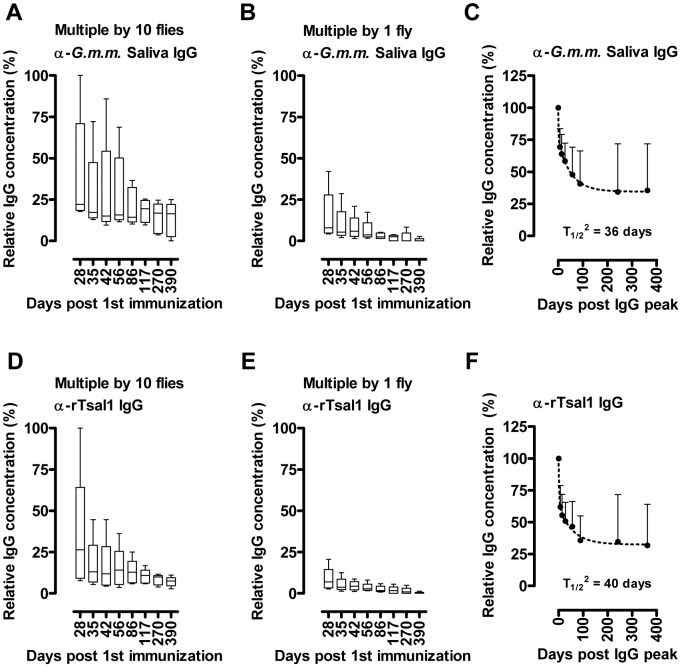
Antibody kinetics in tsetse exposed mice.Evolution over time in the absence of tsetse fly challenge (from day 28 onwards) of the anti-G. m. morsitans saliva IgG concentrations (A, B, C) and the anti-rTsal1 IgG concentrations (D, E, F) in mice (n = 5/group) exposed multiple times to a single fly (B, E) or 10 flies (A, D). Presented data are the IgG concentrations relative to the highest responder plasma and expressed as percent based on a standard dilution series. Box plots represent the means, with minimum and maximum and the 75-25% percentiles. The average antibody half-life (T1/2
2, C, F) over the 2 exposure groups (n = 10) was determined by a two-phase non-linear decay regression (dotted line) of the declining antibody concentrations relative to the concentration recorded after cessation of the tsetse exposure (day 28 set as starting concentration of 100%). Scatter plots indicate the mean concentrations with the 95% CI.